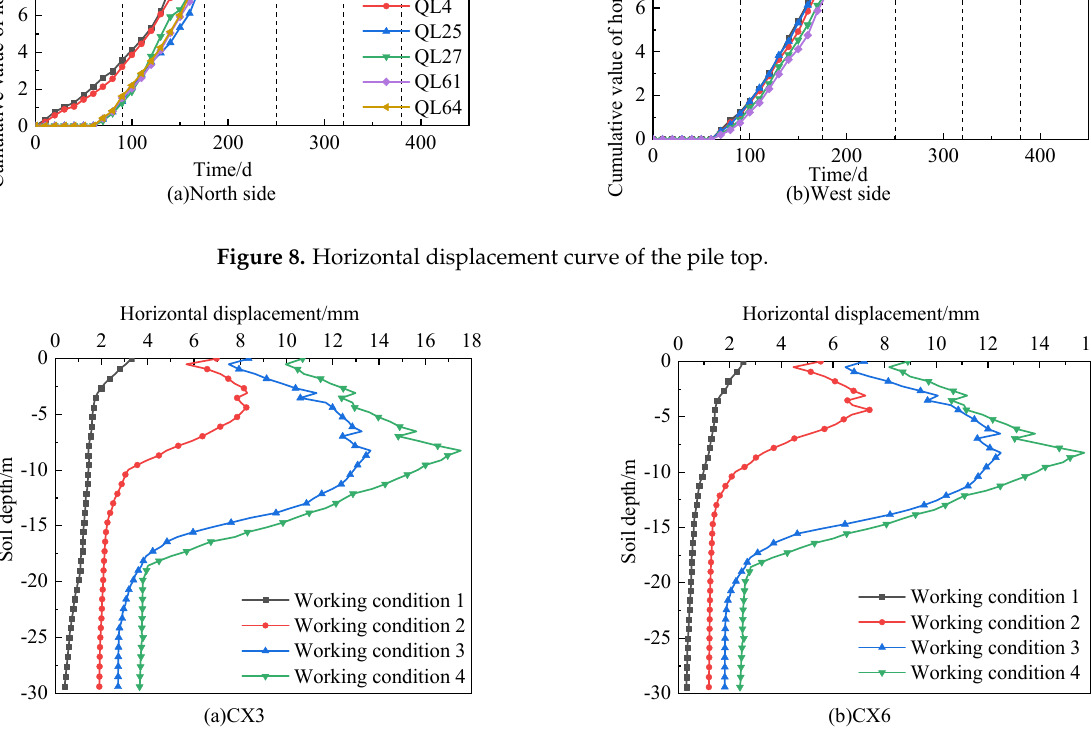
Figure 9. Deep horizontal displacement curve.